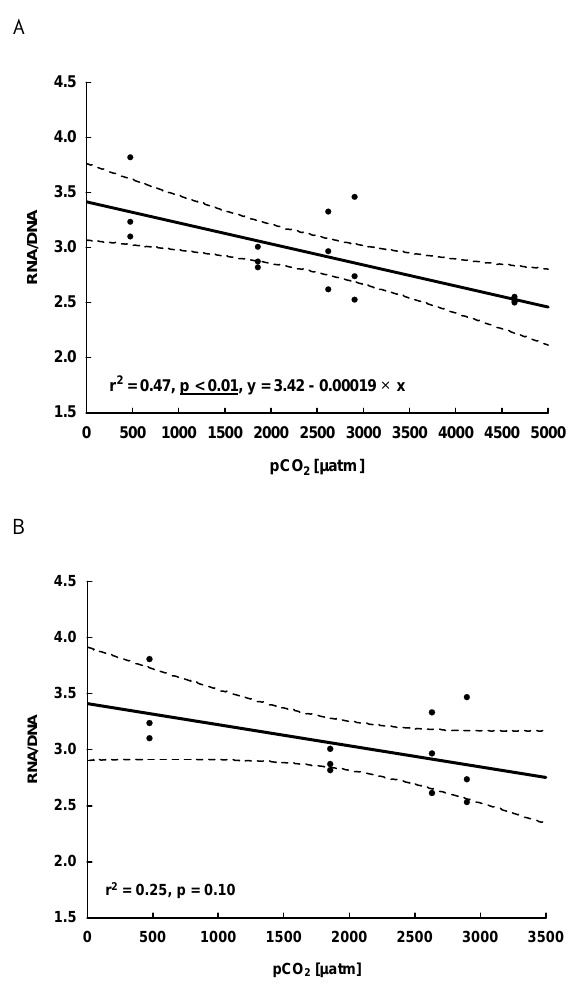
Figure 5. (A) RNA/DNA ratio of newly hatched Atlantic herring larvae across the entire pCO 2 gradient and (B) without the highest treatment level. Due to accidental loss of samples larvae of only 3 replicates per treatment level could be used for nucleic acid determination. Furthermore, nucleic acids could not be examined for treatment level 2. Data points are mean values of 6 individual larvae. The solid line shows the regression line, whereas the dashed lines represent the 95% confidence intervals.